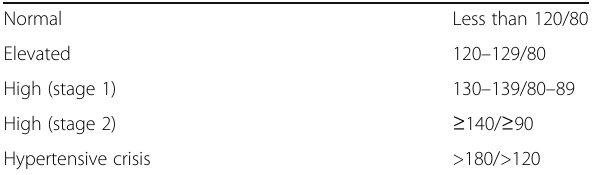
Table 1 Reference values of blood pressure (mmHg) Normal Less than 120/80